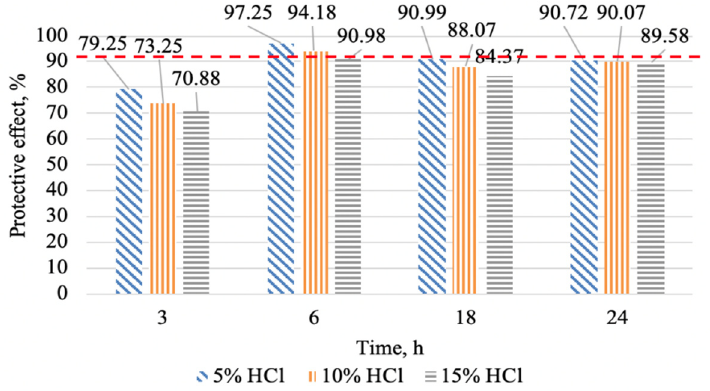
Figure 5. Dependence of the protective effect of the inhibitor in aqueous solutions of HCl on time, conc. IC-1 0.5% wt., t = 20 °C.